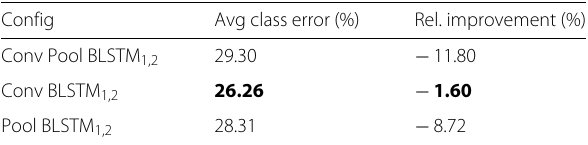
Table 5 Average class error and relative improvement over the baseline system for the RNN classifier with the combination and pooling block before the first BLSTM layer on the test